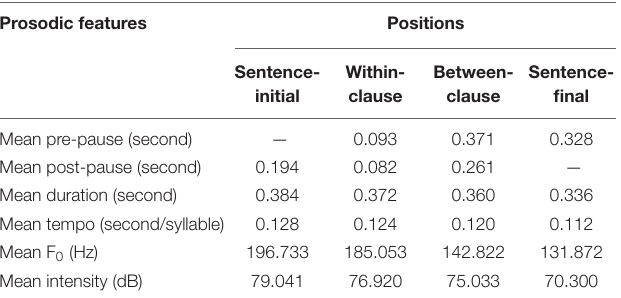
TABLE 3 | Mean values of prosodic parameters of ni zhidao in four sentence positions. Prosodic features